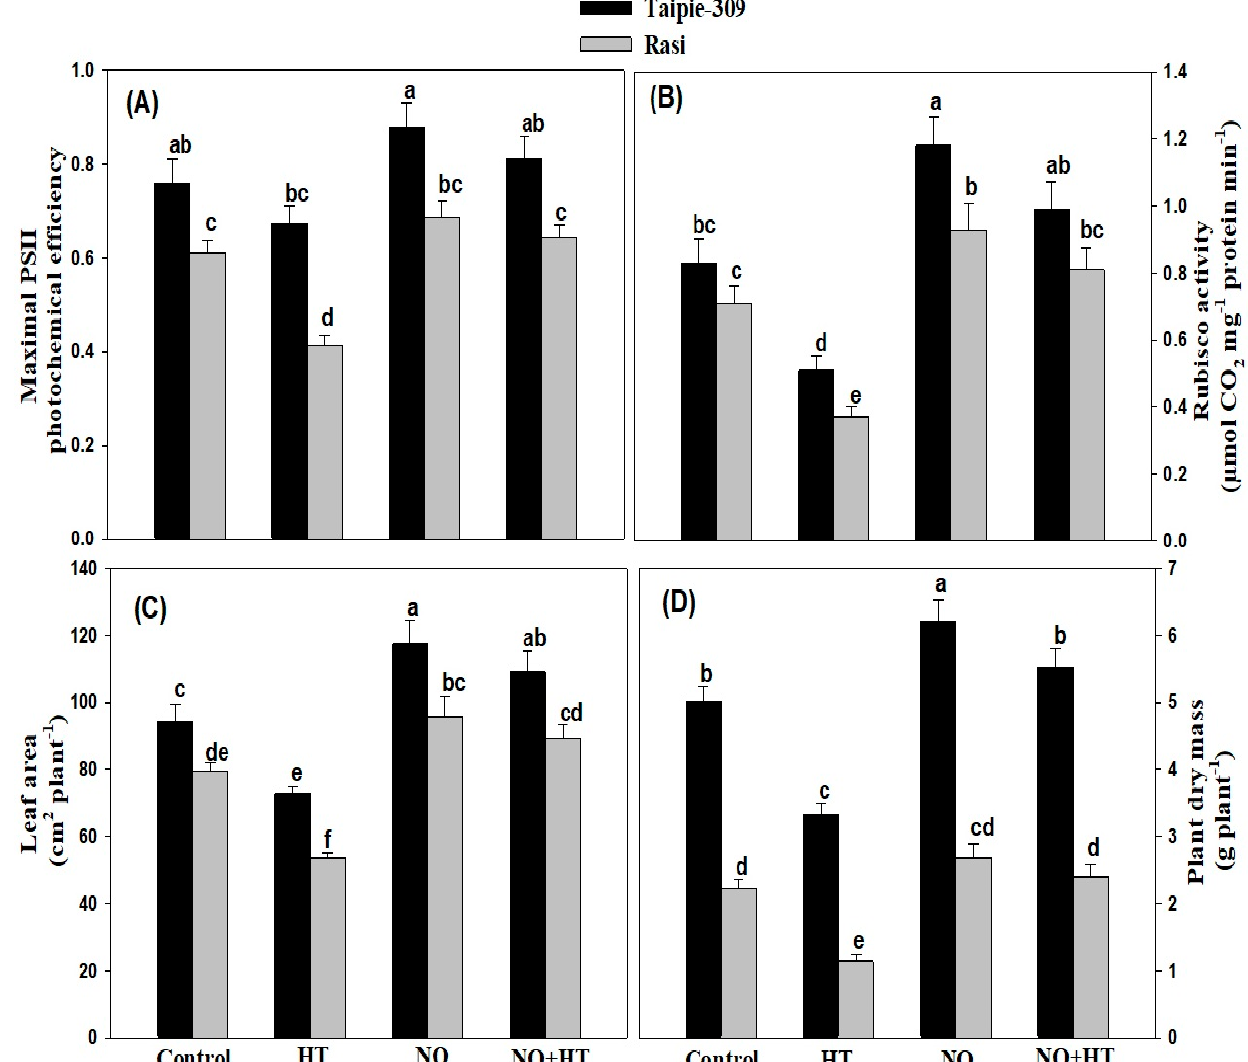
Figure 4. Maximal PSII photochemical efficiency ( A ), Rubisco activity ( B ), leaf area ( C ), and plant dry mass ( D ) in Taipie-309 and Rasi cultivars of rice ( Oryza sativa L.) at 30 days after germination (DAG), plants were grown with/without high temperature stress and treated with foliar 100 µ M SNP (NO donor). Data are presented as treatments mean ± SE (n = 4). The values followed by same letters above bars represent that data did not differ significantly by LSD test at p <